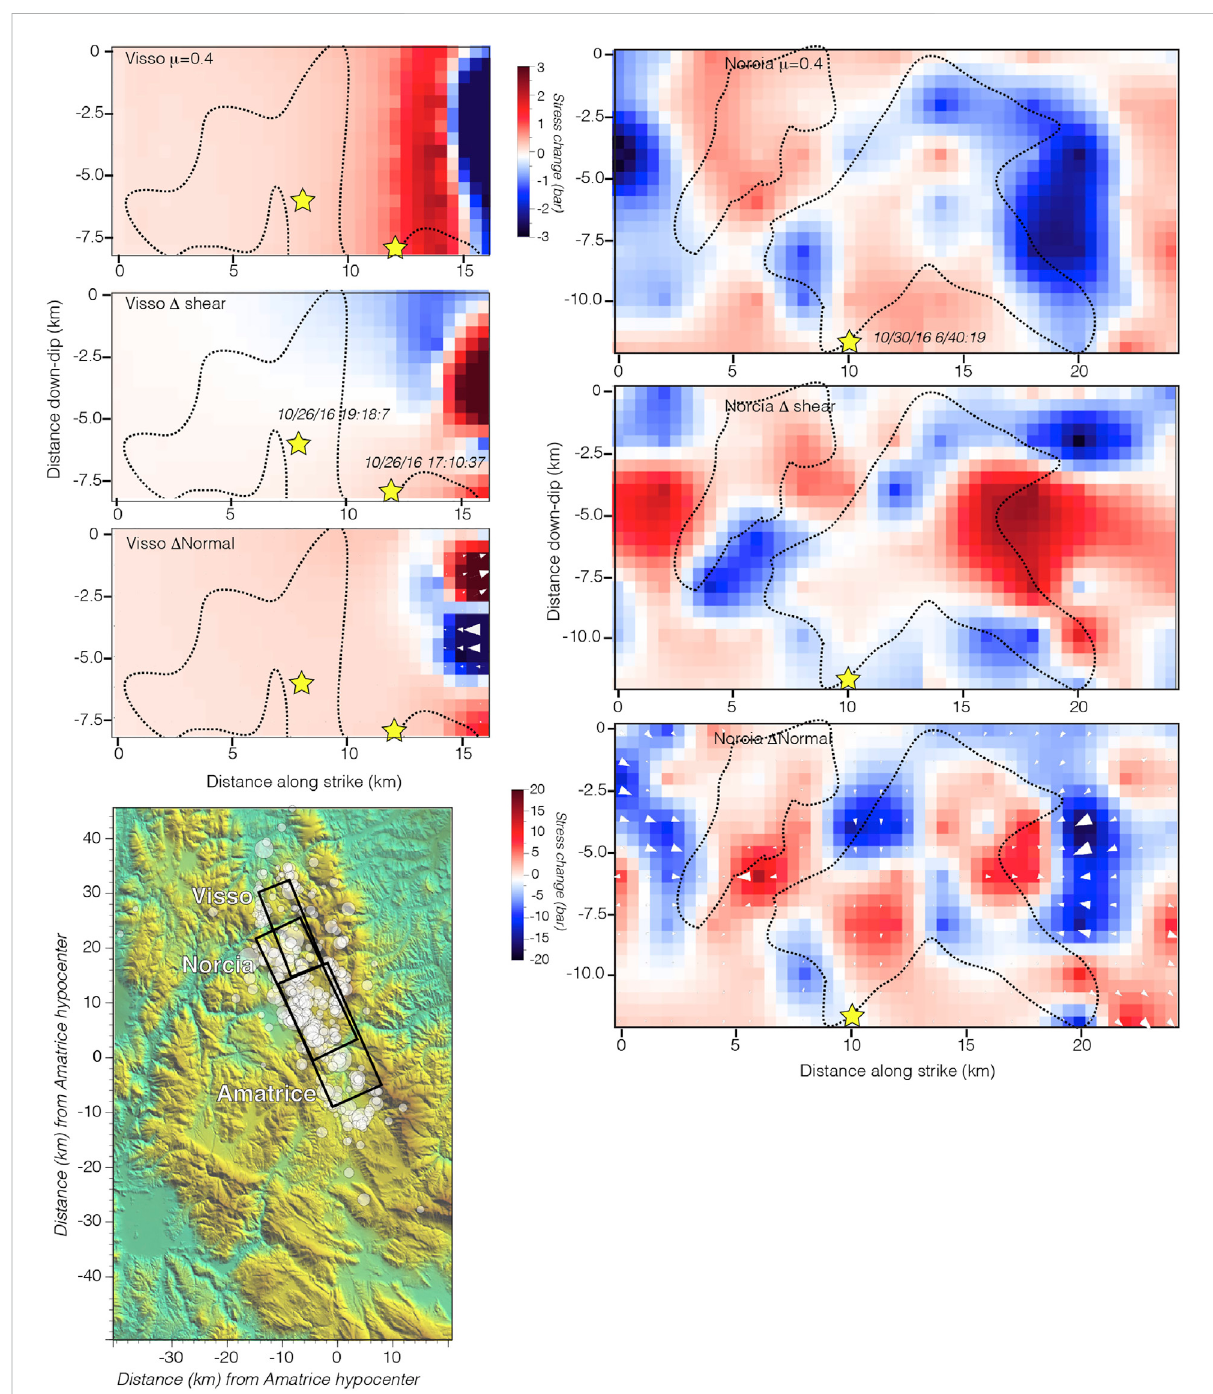
FIGURE 12 Calculatedstaticstresschangesfrom M ≥ 3earthquakesbeginningwiththe24August2016Amatriceearthquakeresolvedontherupturesofthe Visso and Norcia earthquakes (left and right columns, respectively). Hypocenters are shown by yellow stars and approximate slip distributions outlined from solutions by Chiaraluce et al. (2017). Coulomb stress changes are mostly positive on the Visso plane (calculated with an intermediate friction coef fi cient of 0.4). Shear and normal stress changes are also shown. Expected magnitudes and directions of relative fl uid fl ow resulting from normal stress changes are superposed on the normal stress change map for both the Visso and Norcia ruptures. The Norcia plane shows very complex patterns of stress change and fl uid fl